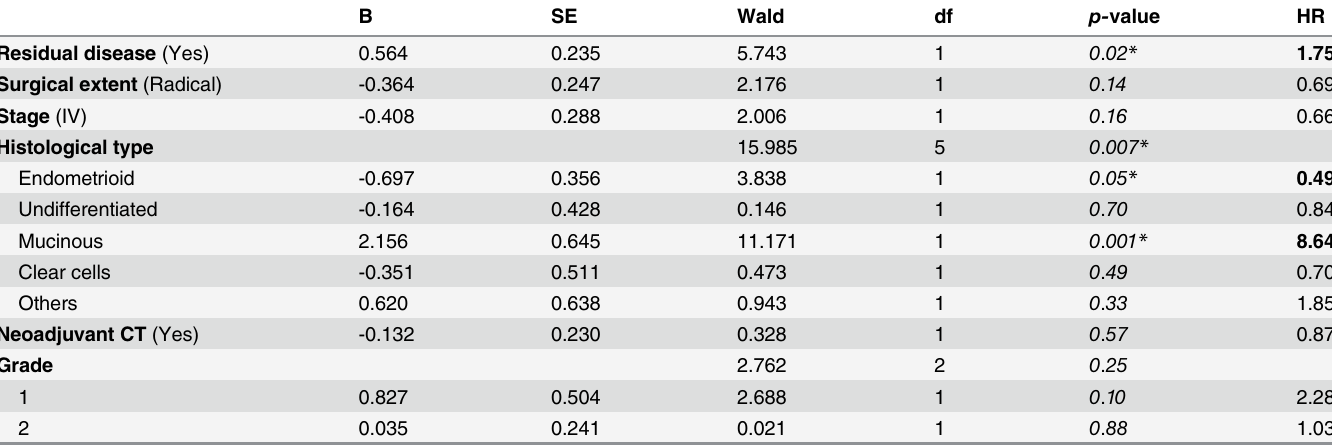
Table 3. Cox logistic regression in Early Relapse group: multivariate analysis.